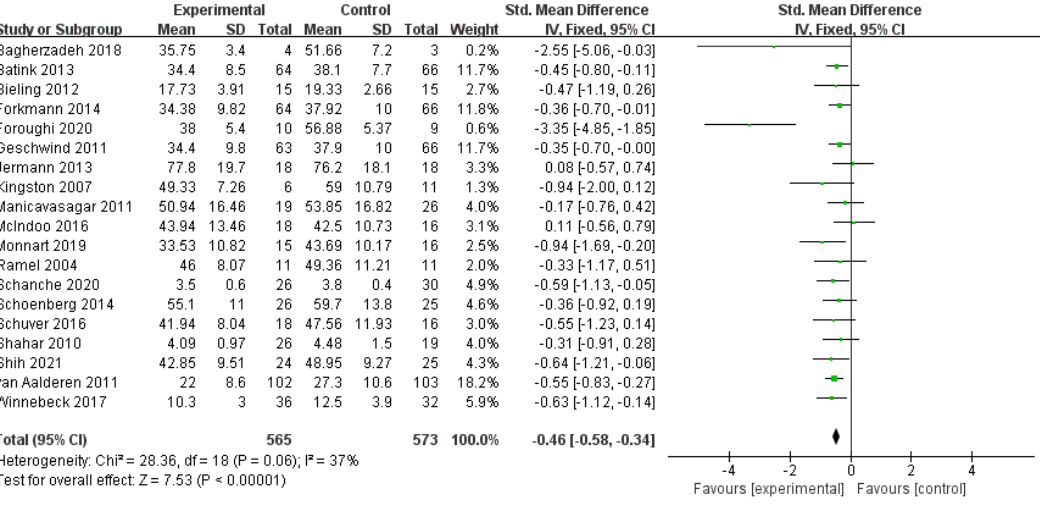
Figure 3. Meta − analyses of the effects of MBIs on rumination [30–48].